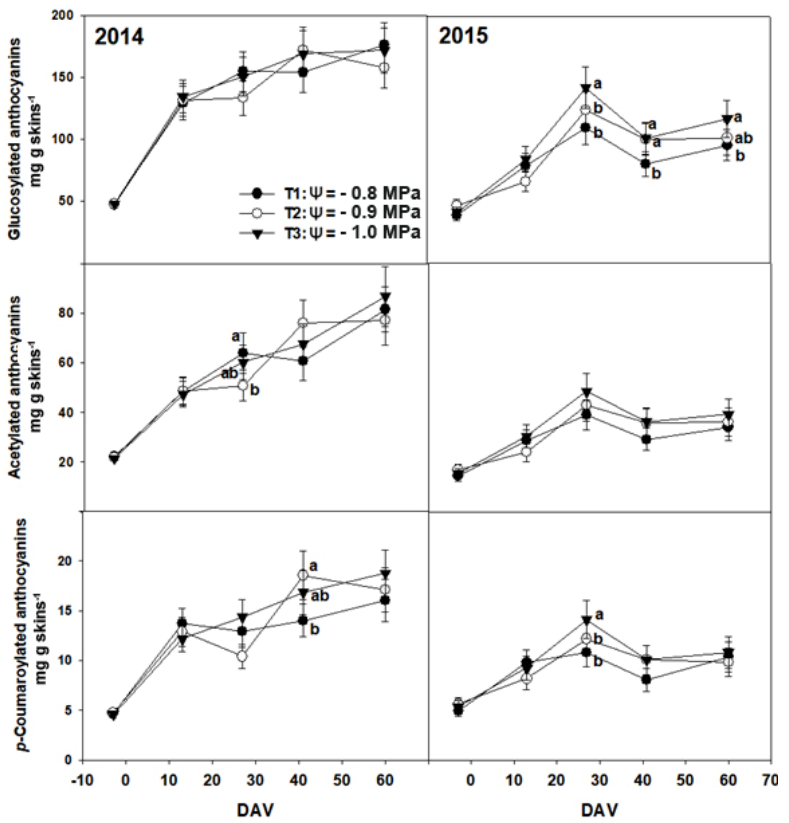
Figure 2. Glucosylated, acetylated and p -coumaroylated anthocyanin concentrations in Cabernet Sauvignon grape skins throughout ripening in the 2014 and 2015 seasons. Vertical bars indicate standard error from five replicates. Different letters indicate significant differences between treatments (Tukey’s HSD test, p < 0.05). For the number of substitutes in the B-ring of the chemical structure of anthocyanins, the concentration of dihydroxylated anthocyanins went from 10.58 to 26.78 mg g − 1 in 2014 and from 5.94 to 15.04 mg g − 1 in 2015 yet did not show clear effects by irrigation treatment (Figure 3). In contrast, the trihydroxylated anthocyanins ranged from 35.97 to 150 mg g − 1 in 2014 and from 34.29 to 127.03 mg g − 1 in 2015 (Figure 3). The trihydroxylated anthocya- nins were much higher in concentration than the dihydroxylated counterparts in both sea- sons, resulting in a strong reduction in the dihydroxylated-to-trihydroxylated ratio, with no significant differences between treatments. The evolution of these compounds was sea- son-dependent, with a progressive increase in concentration in 2014, while in 2015, a tran- sient reduction was observed at 30 DAV, slightly increasing again from 40 DAV. Addi- tionally, in 2015, the most restrictive irrigation treatment resulted in a higher concentra- tion of trihydroxylated anthocyanins (Figure 3).